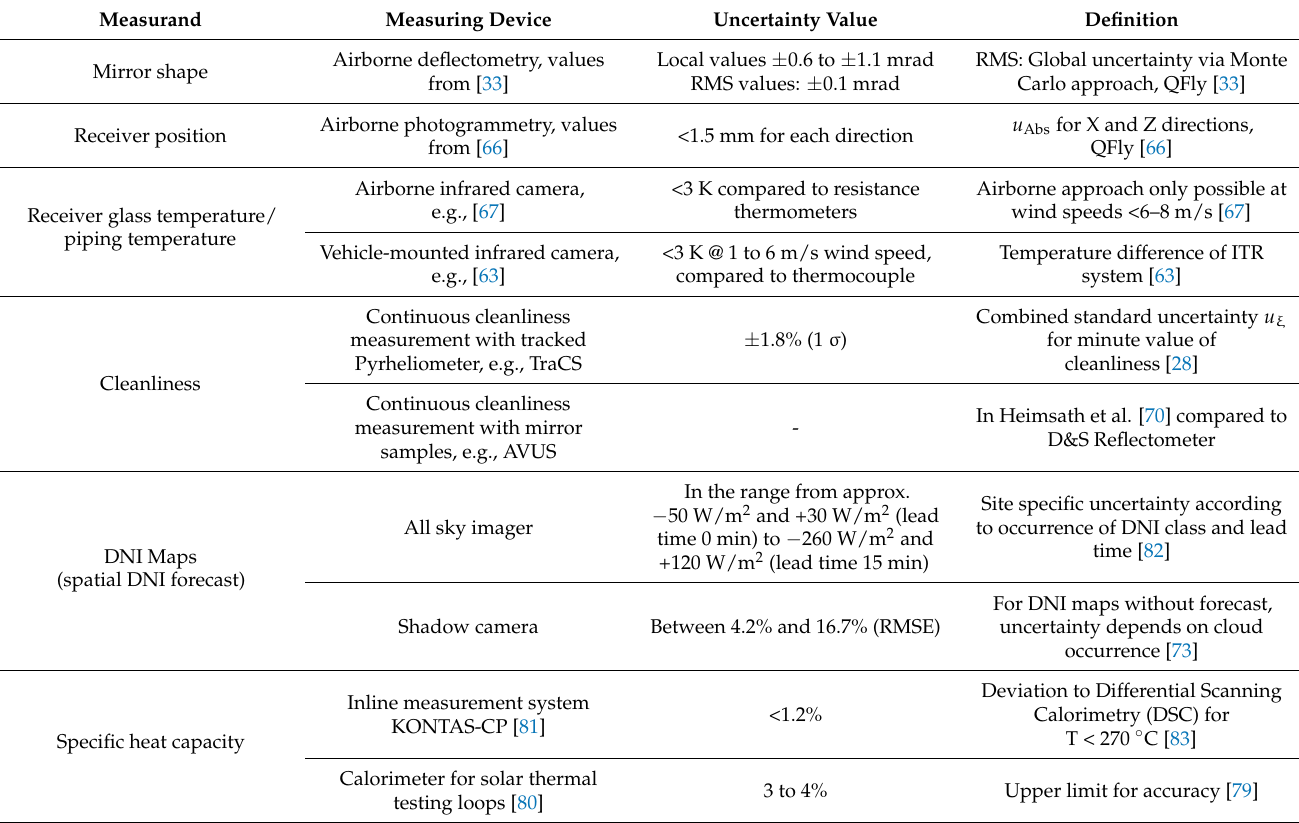
Table 7. Selected new measurement approaches for the monitoring of parabolic trough